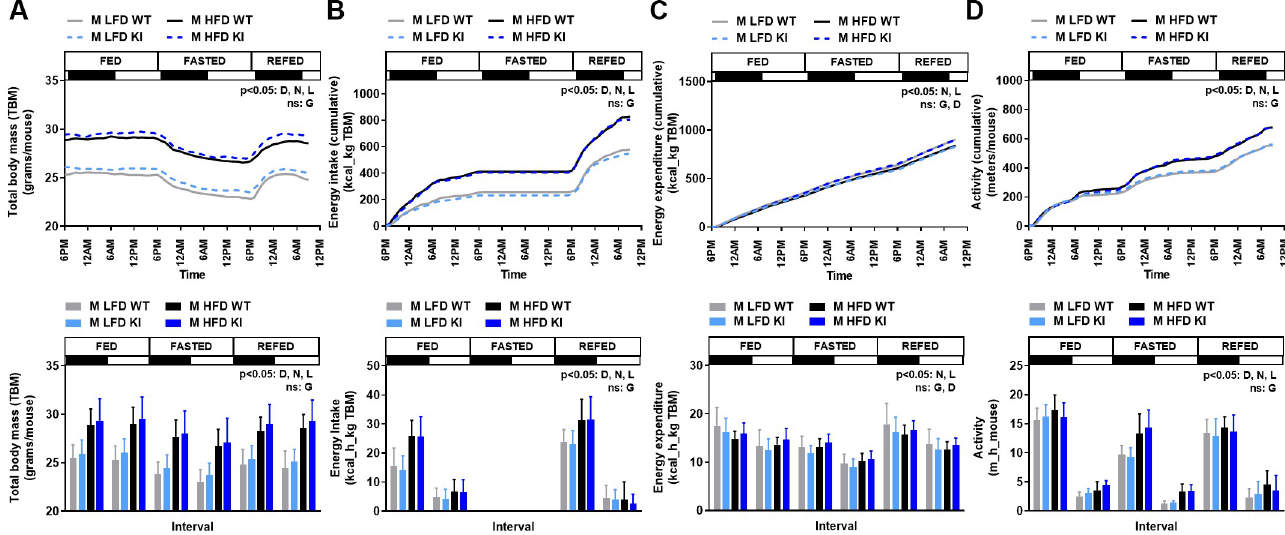
Fig 3. Effect of the CREBRF R458Q variant on energy homeostasis in response to acute ( < 24h fasting/refeeding) or chronic (high-fat diet) nutritional stress in mice. Male (M, 12-week-old, n = 7-12/group) wild-type (WT) and knockin (KI) mice fed control low-fat diet (LFD) or high-fat diet (HFD) were evaluated for changes in total body mass (A) , energy intake (B) , energy expenditure (C) , and activity (D) in response to changes in nutritional status (fed, fasted, refed) over time using indirect calorimetry and activity monitors (Sable System). The protocol was as follows: 24–36 hours of acclimation, 24 hours of ad lib feeding (6PM- 6PM), 24 hours of fasting (6PM-6PM), 15 hours of refeeding (6PM-9AM). Feeding status and lighting status (dark = black bar; light = white bar) are shown on the top of each graph. Data are presented in two ways: Top row = mean (without SD for figure clarity) for each variable over the course of the entire study ( A = absolute value, B-D = cumulative values); or Bottom row = mean (SD) for each variable during each 12-hour light-dark interval ( A = absolute value; B-D = average per hour for that interval). Generalized estimated equations with time as a within subject variable were used to compare the above dependent variables between D = diet (LFD, HFD), N = nutritional status (fed, fasted, refed), L = lighting status (dark, light), and G = genotype (WT, KI) as fixed factors. Main effects with a significance level of p < 0.05 are indicated. Main effects with a significance level of � 0.05 are labeled as non-significant (ns).